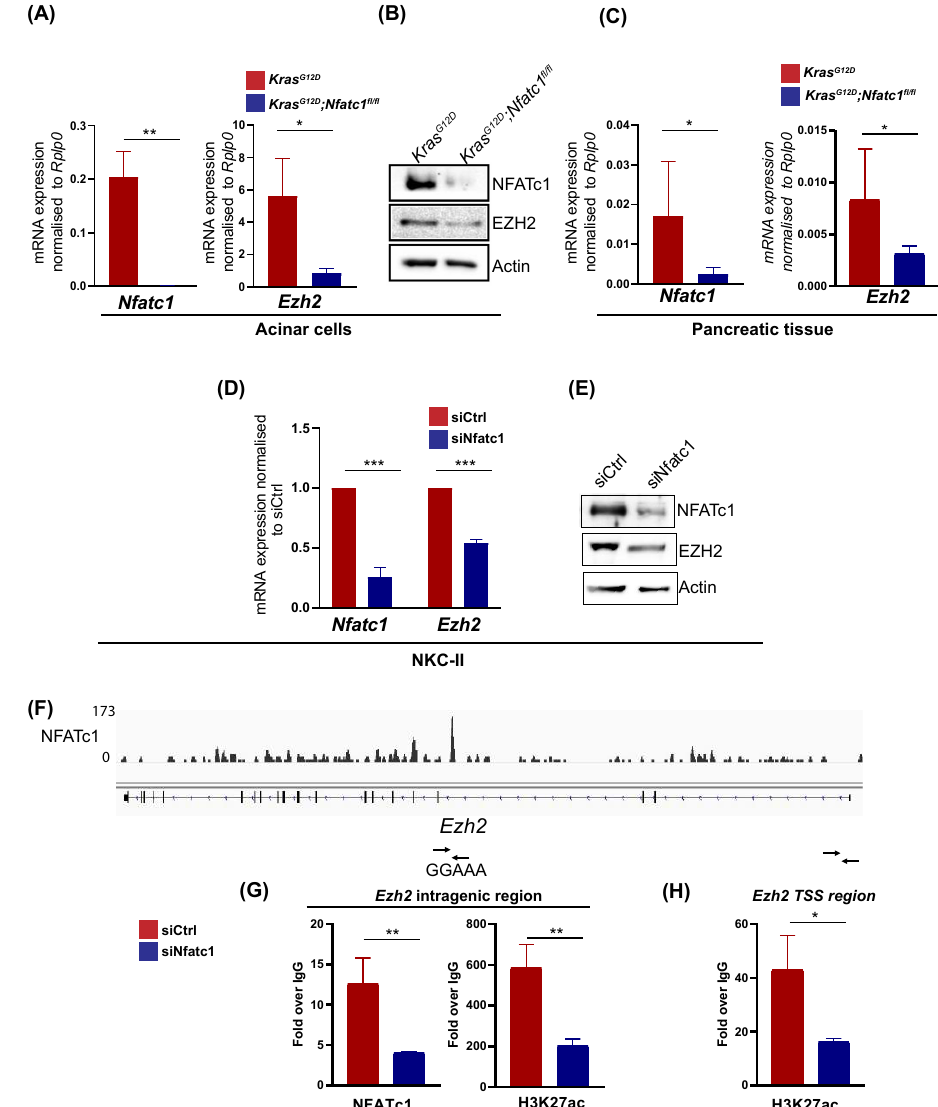
Figure 2. NFATc1 induces EZH2 expression at the level of gene transcription. ( A ) Nfatc1 (left) and Ezh2 (right) mRNA expression in acinar cells isolated from Kras G12D and Kras G12D ;Nfatc1 fl/fl mice ( n = 3 mice/genotype). Values represent mean +/ − SD (two-tailed unpaired student’s t -test). ( B ) NFATc1 and EZH2 expression in whole cell lysates obtained from acinar cells isolated from